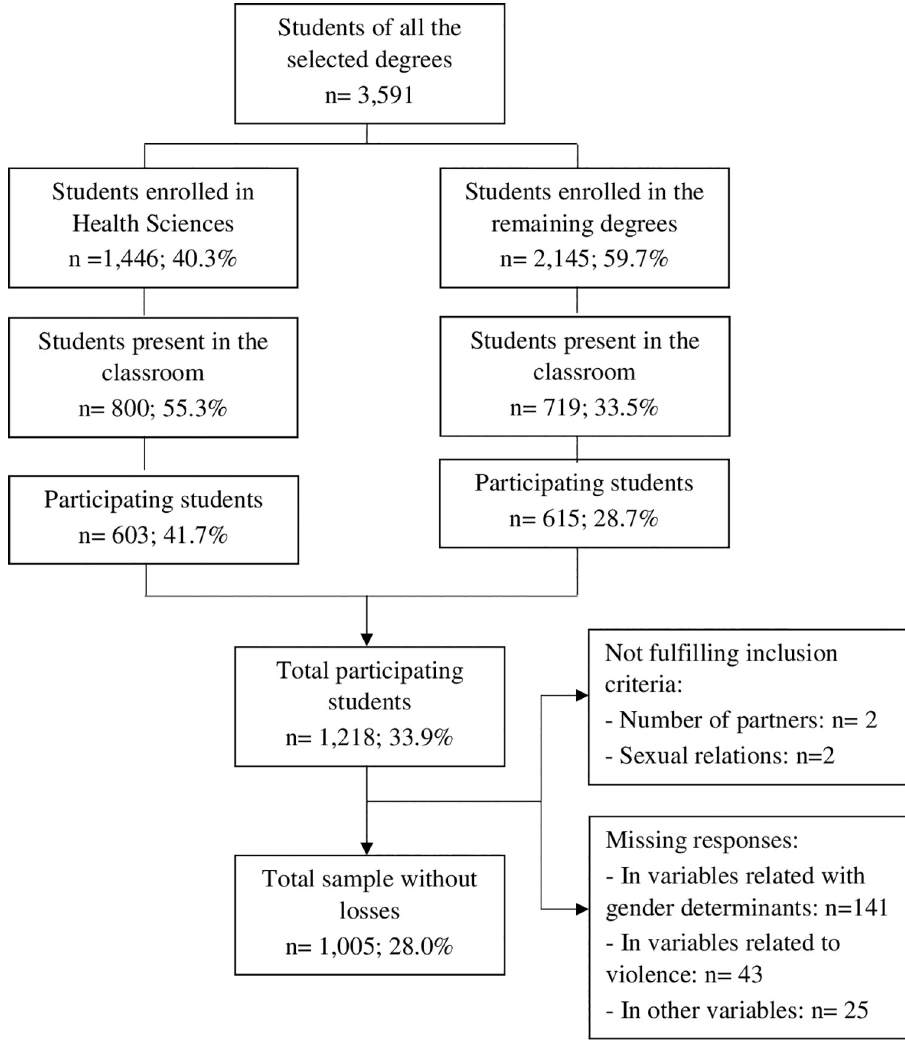
Fig 1. Recruitment process of the study